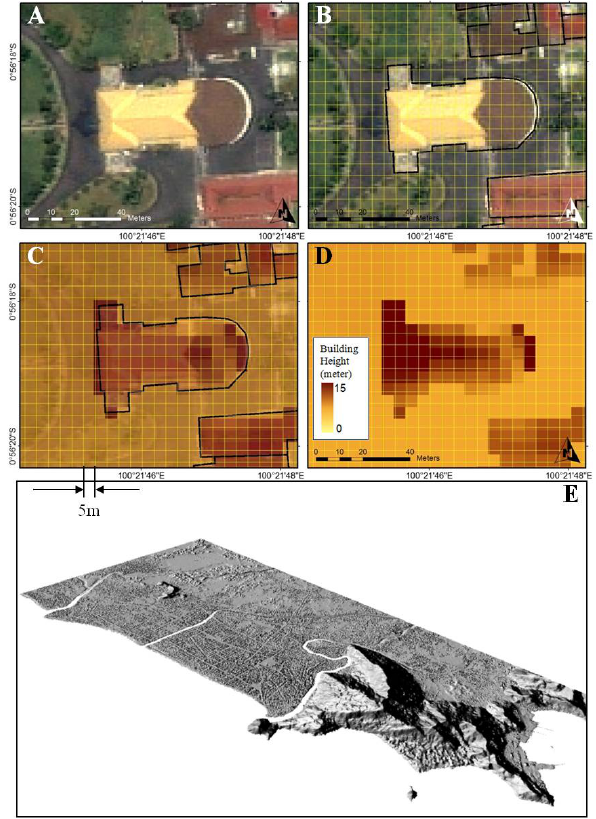
Fig. 4. The process of input data preparation for Topographic Model.